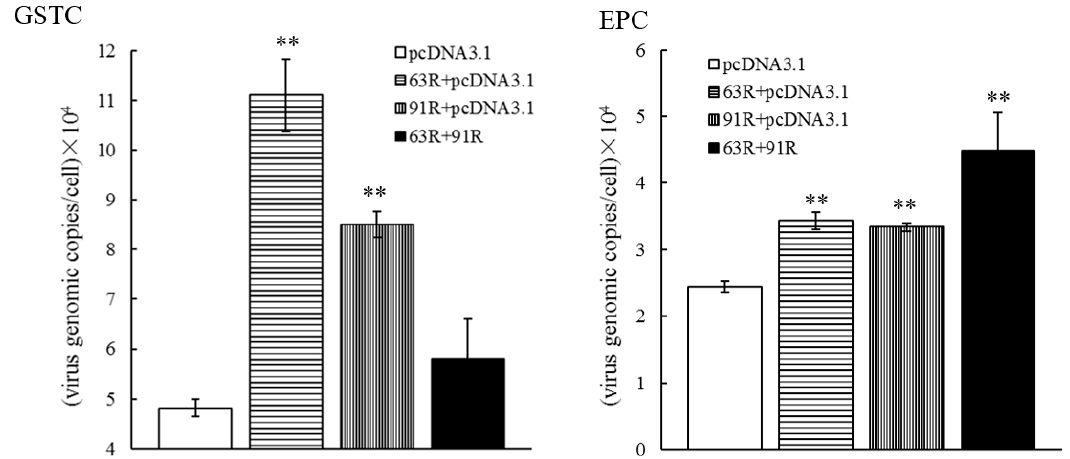
Figure 5. qPCR analysis of RGV genomic copies in GSTCs or EPCs. GSTC: in GSTCs expressing protein RGV-63R (63R + pcDNA3.1) or RGV-91R (91R + pcDNA3.1) alone or co-expressing two proteins RGV-63R and RGV-91R (63R + 91R), respectively. EPC: in EPCs expressing protein RGV-63R (63R + pcDNA3.1) or RGV-91R (91R + pcDNA3.1) alone or co-expressing two proteins RGV-63R and RGV-91R (63R + 91R), respectively. The empty vector pcDNA3.1 was used as a control. The transfected cells were infected with RGV, and RGV genome DNA was extracted from the cells at 48 hpi and quantified by qPCR. Each data point represents the average value of three independent infections. Error bars indicate standard deviations. ** represents p < 0.01.